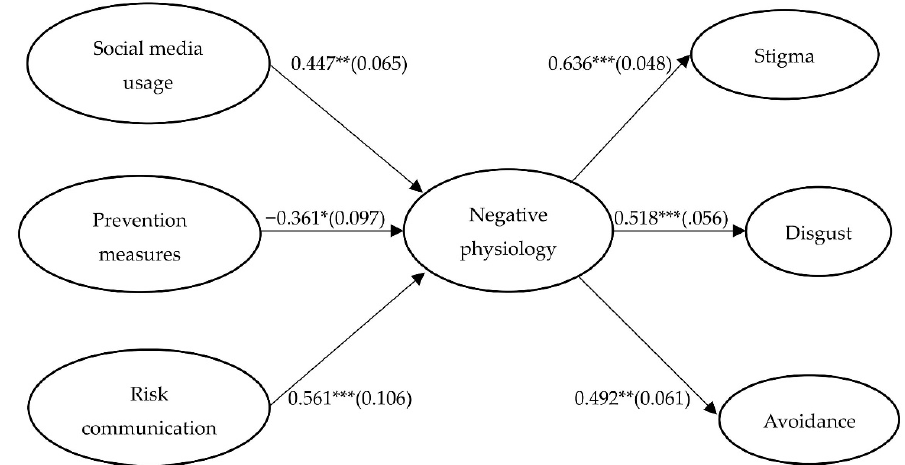
Figure 3. Statistical model. Note. * p < 0.05, ** p < 0.01, *** p < 0.001.